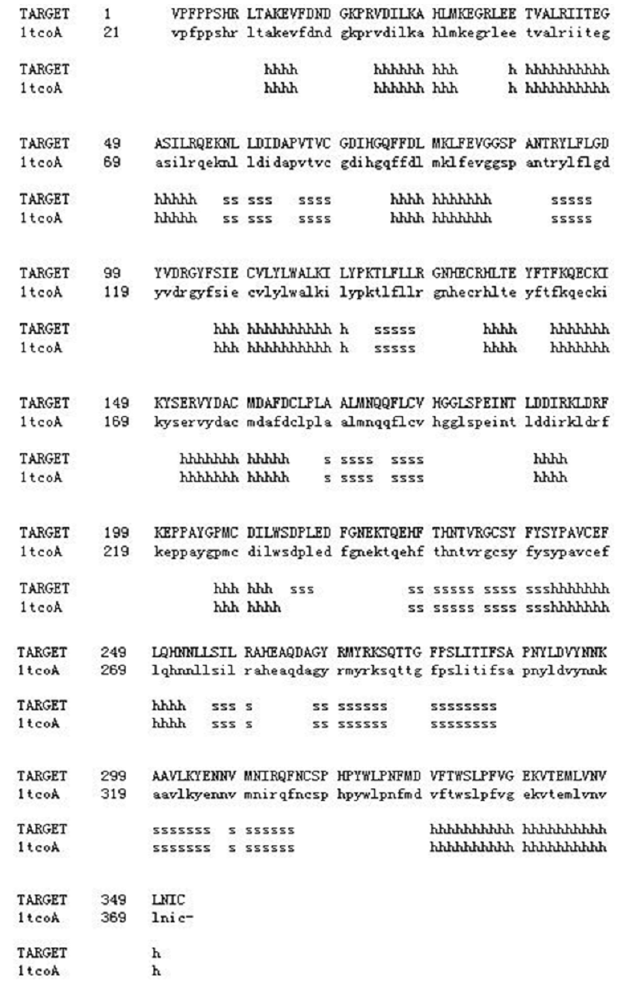
Figure 5. Alignment of the Tianfu goat PPP3CA and ZN505 amino acid sequences. TARGET represents Tianfu goat PPP3CA (1–352 AA), 1tcoA represents ZN505 (21–372 AA); s indicates the residues that form the “bend”; and h indicates the residues that form the “ α